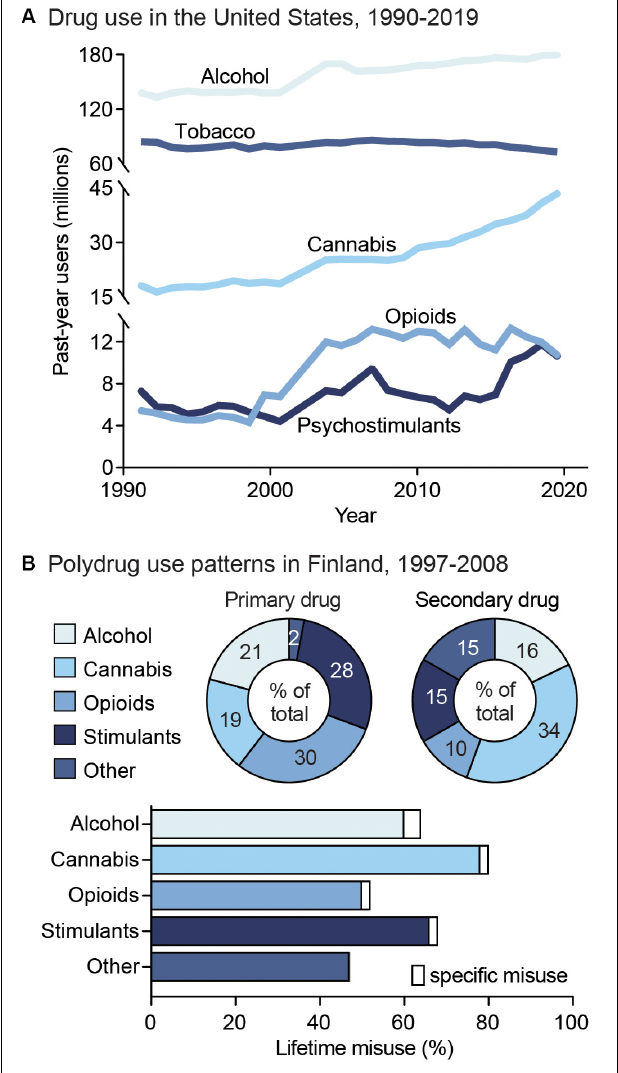
FIGURE 1 | Public health trends in drug use. (A) Drug use in the United States from 1990 to 2019. Data from the National Household Survey on Drug Abuse (Substance Abuse and Mental Health Services Administration, 1993, 1995, 1997, 2003) and the National Survey on Drug Use and Health (Substance Abuse and Mental Health Services Administration, 2005, 2007, 2009, 2011, 2013, 2015, 2017, 2019). (B) Unspecified polysubstance use in treatment-seeking drug users in Finland from 1997 to 2008. Top : Primary (left) and secondary (right) drugs used by treatment-seeking drug users, shown as percent of total users. Bottom : Percent of users reporting exclusive misuse of one drug (white bars) or misuse of a given drug along with polysubstance use of another (colored bars). Data from Onyeka et al.